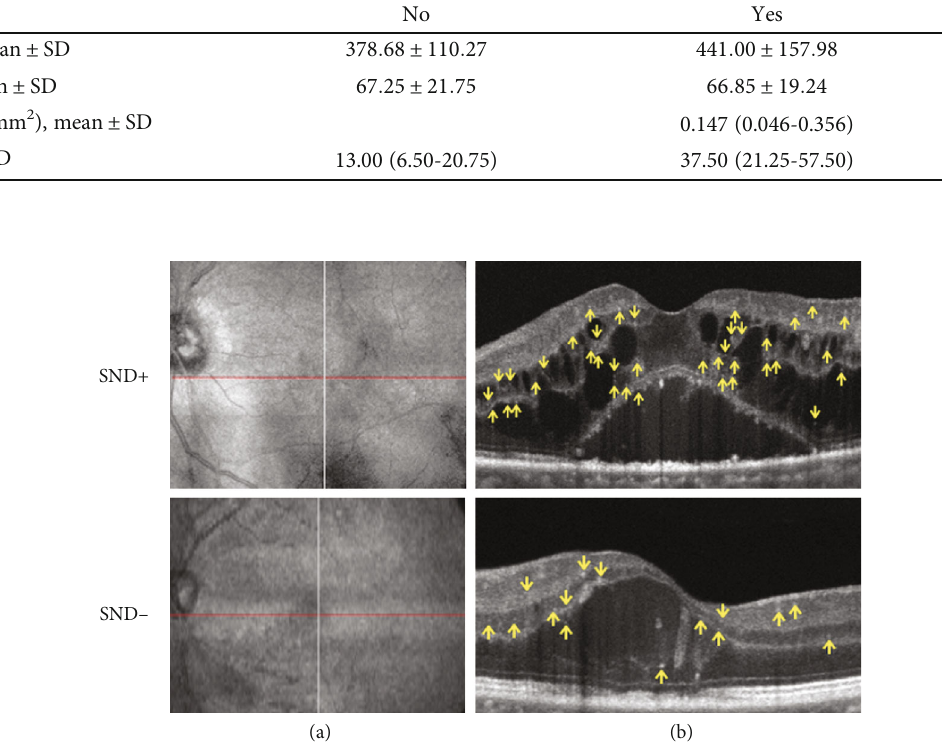
Figure 3: Infrared re fl ectance image from the optical coherence tomography angiography image; the red line indicates the position of the B- scan (a). B-scan obtained in the enhanced imaging mode showing cystoid macular edema, subfoveal neuroretinal detachment, and the number of hyperre fl ective retinal spots (HRS) as indicated by the yellow arrows within the central 3 mm (b).